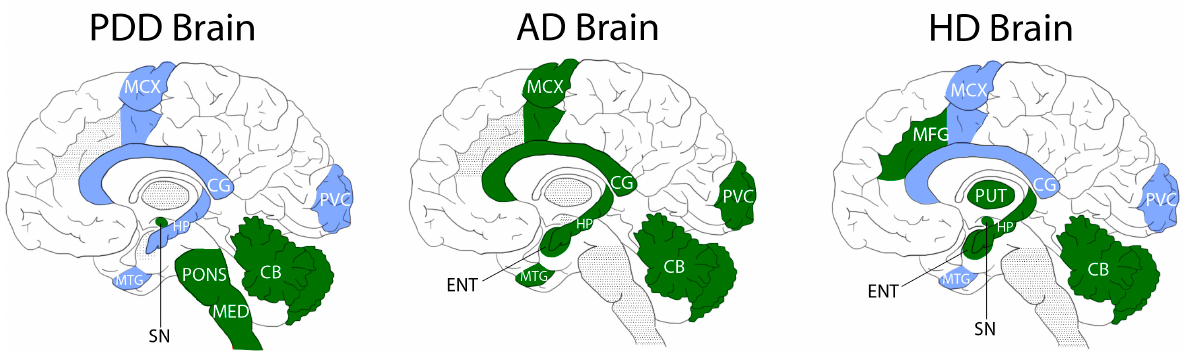
Figure 2. Regional Distribution of Pantothenic Acid Decreases in the PDD, ADD, and HD Brain. Areas shaded in green denote regions with significant decreases in pantothenic acid compared to matched cohort controls. Areas shaded in blue denote regions showing no significant case–control differences. Areas shaded in grey denote regions that were not investigated.